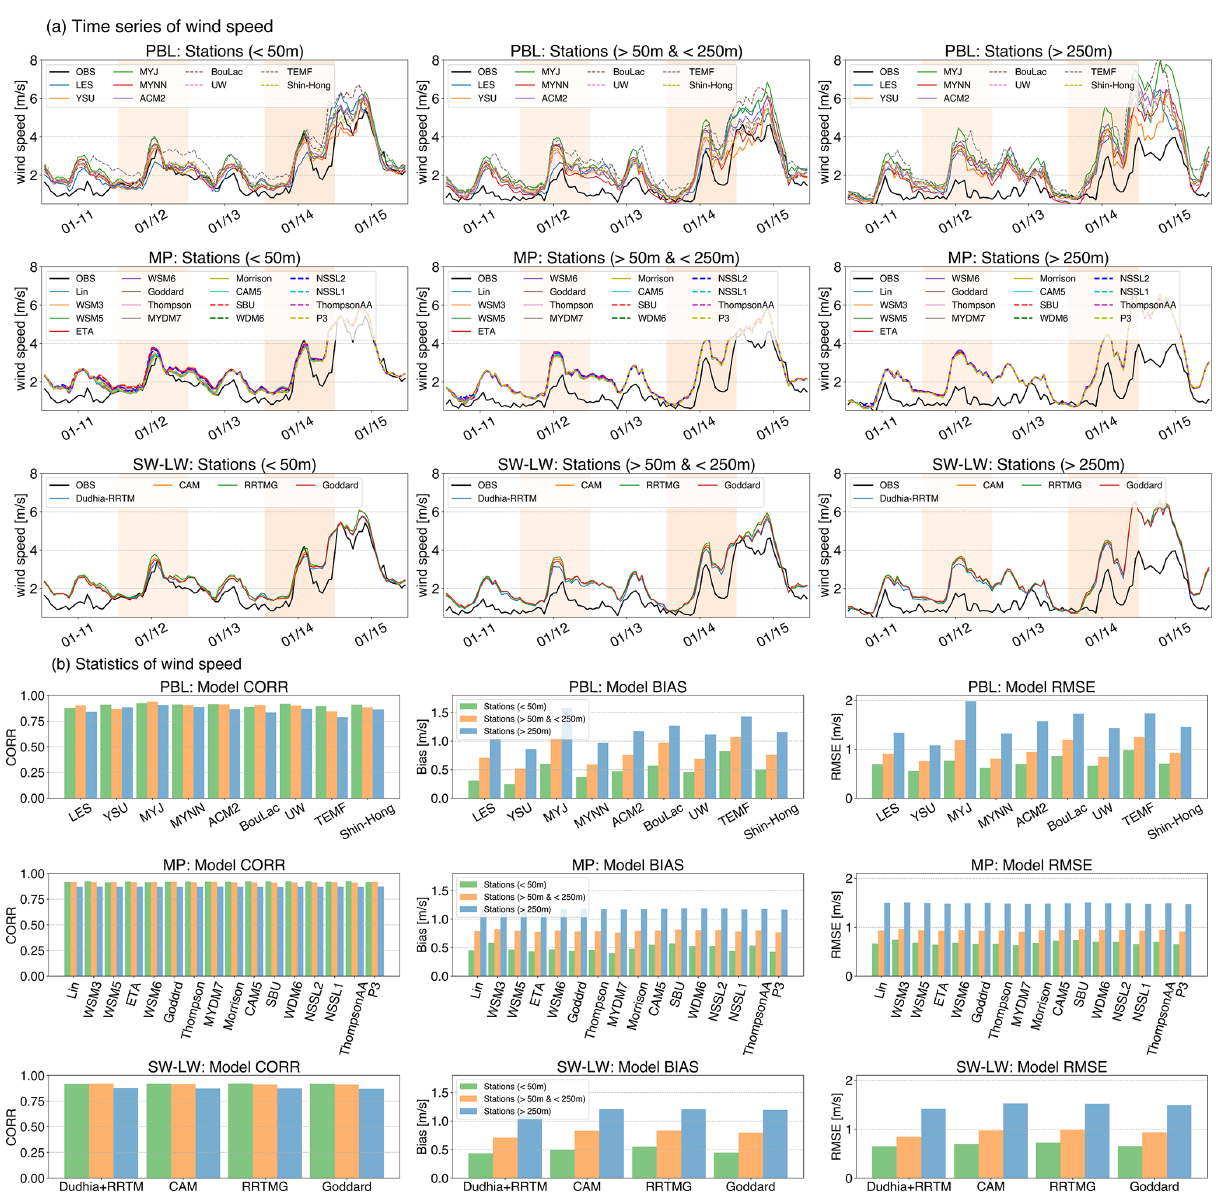
Figure 12. Comparison of simulated wind speeds (ms − 1 ) for stations < 50m (51 stations in total), > 50, and < 250 (36 stations in total), and > 250m (19 stations in total) and the corresponding statistic